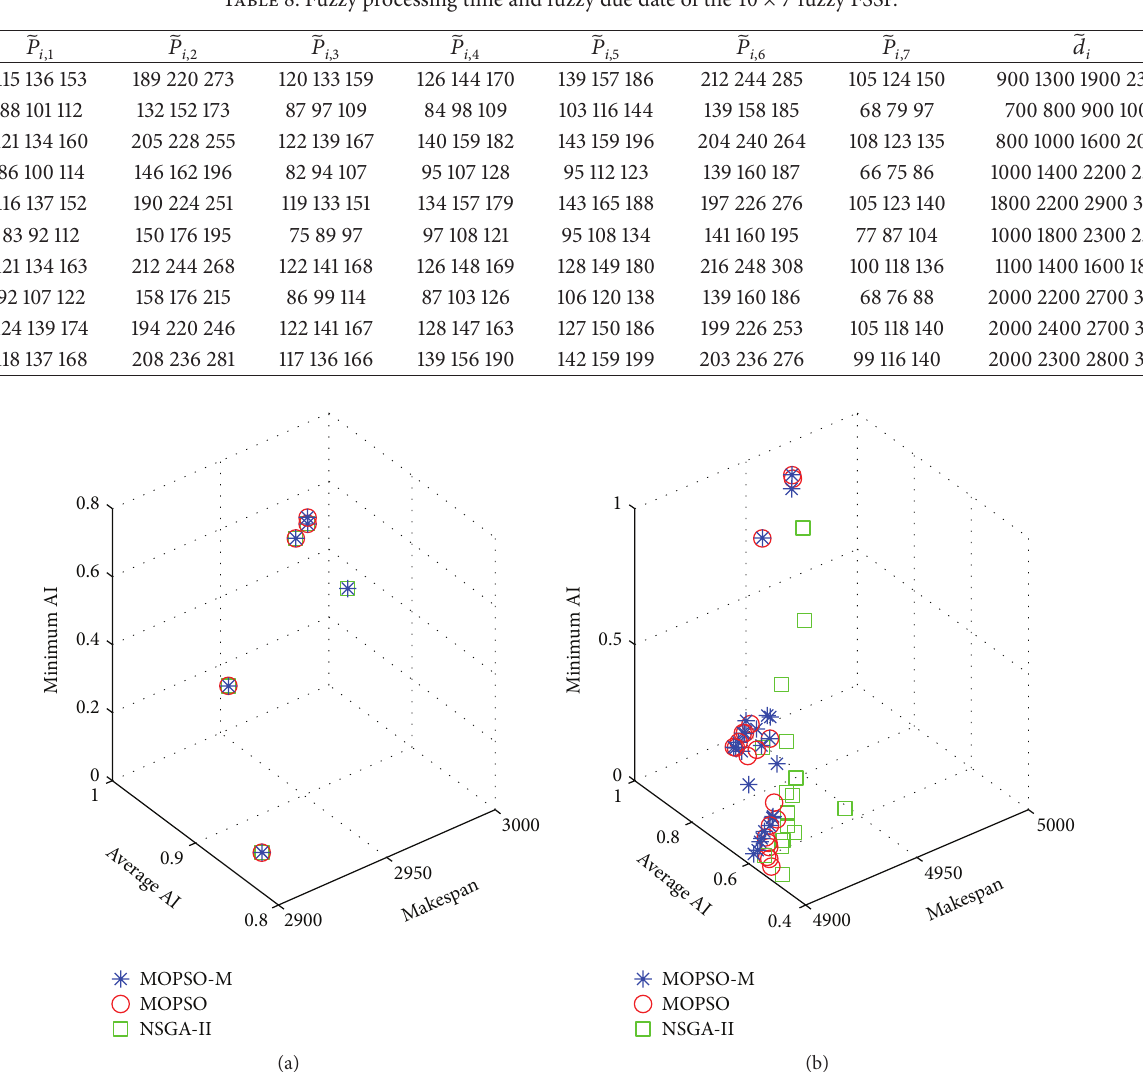
Figure 4: Distribution of optimal objective vectors generated by MOPSO-M, MOPSO, and NSGA-II in the performance evaluation